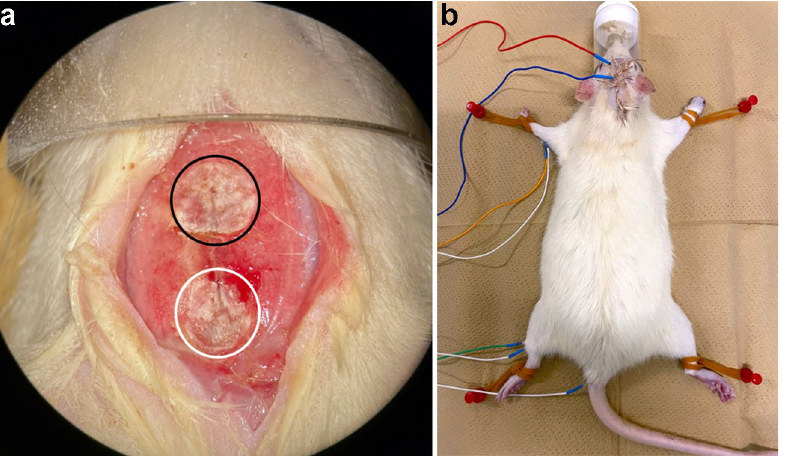
Figure 5. ( a ) The procedure of skull thinning. The outer layer and diploe of the skull were resected with the size of 5 mm diameter at both bregma and lambda by the diamond drill. The black circle indicates the bregma after bone thinning, and the white circle indicates the lambda after bone thinning. The anode was placed at lambda and the cathode at bregma. ( b ) The red electrode is an anode which is inserted into the bregma position. The blue electrode is a cathode which is inserted into the lambda position. Two electrodes were inserted in the left forelimb’s extensor muscles and the left hindlimb’s quadriceps muscles, respectively, and the ground wire was inserted into the tail. Transcranial electrical stimulation motor evoked potentials were recorded under general